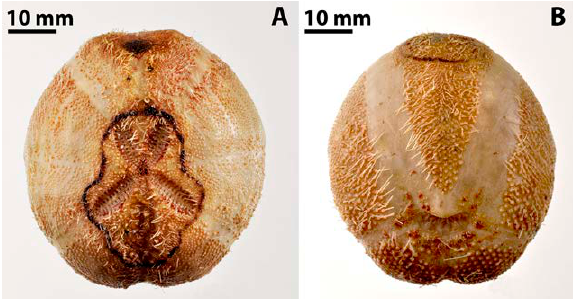
Fig. 6. – Brissopsis lyrifera A, oral view; B, ventral view (Photo from A.